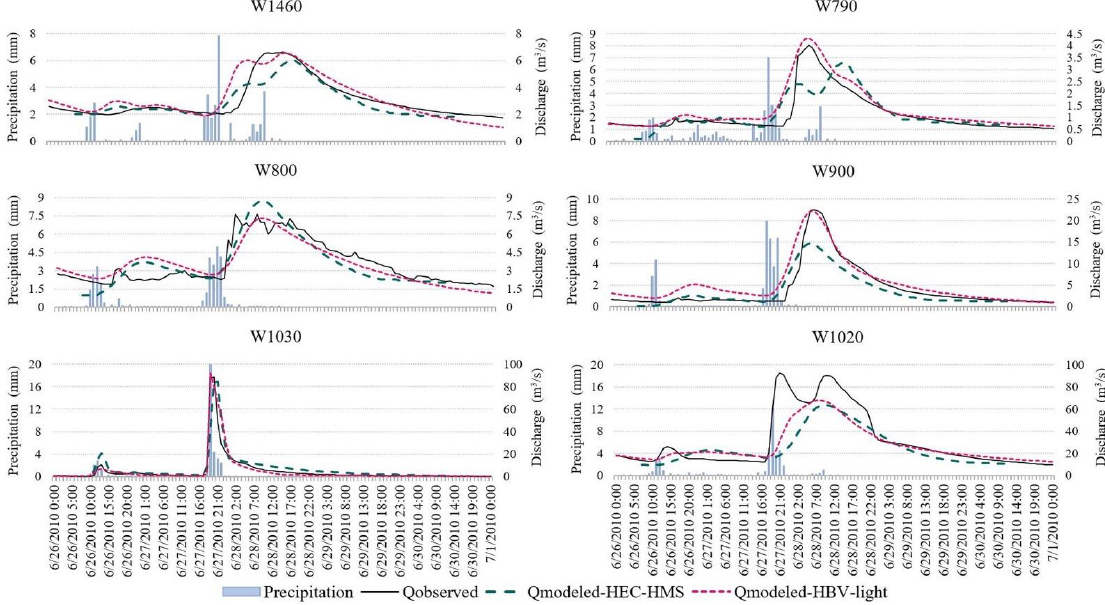
Figure 7. Precipitation, observed and modeled discharge of the 26 – 30 June 2010 rain event at the six gauged stations.